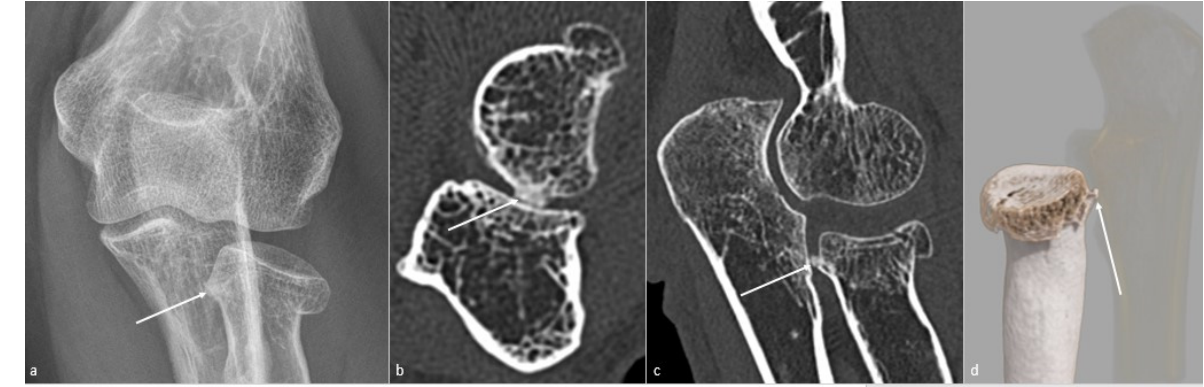
Figure 4. Posttraumatic radial head vicious bone callus. A vicious posttraumatic radial head bone callus (white arrow), causing forearm rotation dysfunction in a 47-year-old woman, is poorly defined on ( a ) an anteroposterior radiograph. The